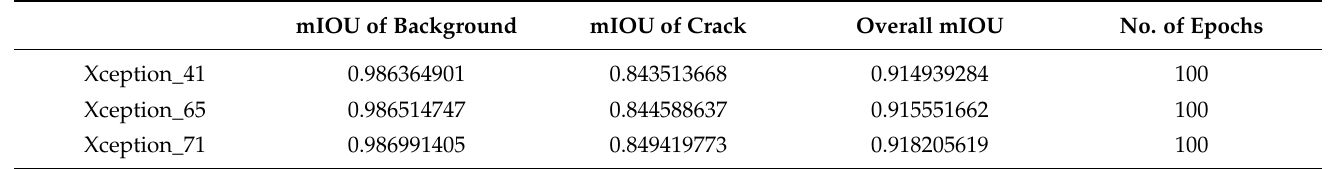
Table 5. The mIOUs of the selected three models.